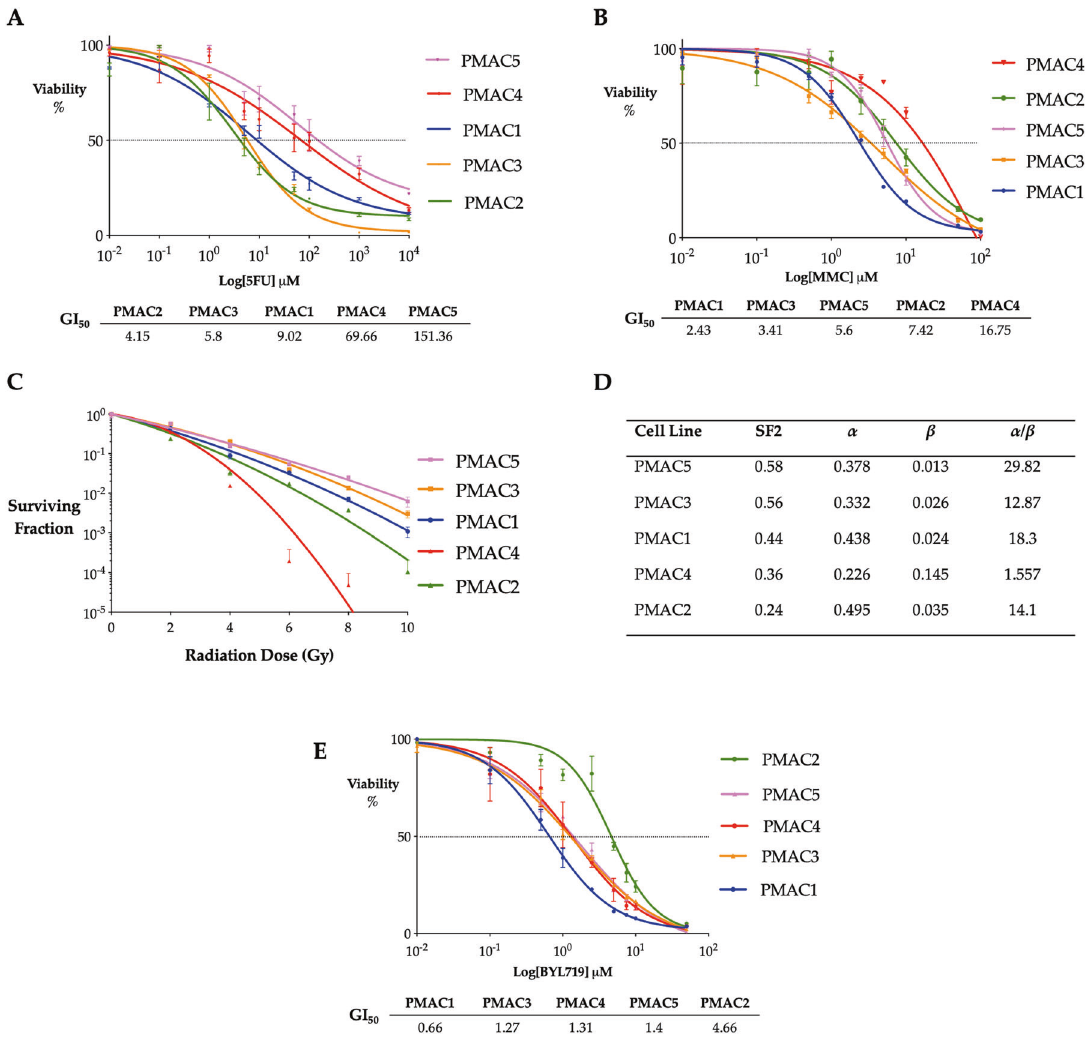
Fig. 7 Chemotherapy, radiotherapy and molecular targeted therapy assessment in the ASCC cell lines. A , B . In vitro 5-FU and MMC cytotoxic assays. Dose – response curves for single agent treatment of the panel of ASCC cell lines for 96 h with viability quanti fi ed by an AlamarBlue ® assay. Data are expressed as percent of vehicle treated control. Shown are mean ± SEM from three independent experiments, GI 50 presented below. C Radiation dose-response curves for the human ASCC cell lines. Radiation survival curves demonstrate the survival fraction (log10) following irradiation with 2, 4, 6, 8 and 10 Gy for the panel of fi ve human ASCC cell lines (mean ± SEM from three independent experiments). D Data points were fi tted with the linear quadratic equation, with the radiotherapy surviving fraction of 2 Gy (SF2) and the α and β values and α / β ratio for each cell line calculated. E Dose – response curve for treatment of the panel of ASCC cell lines with BYL719 for 96 h with viability quanti fi ed by an AlamarBlue ® assay. Data are expressed as percent of vehicle treated control. Shown are the mean ± SEM for three independent experiments, GI 50 presented